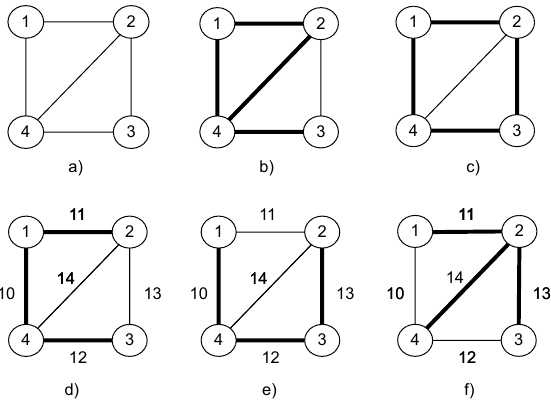
Figure 1. Graph terminology: a) Connected graph; b) closed walk (3-4-2-1-3); c) Cycle (4-1-2-3-4); d) spanning tree; e) minimal cost spanning tree; f) maximal cost spanning